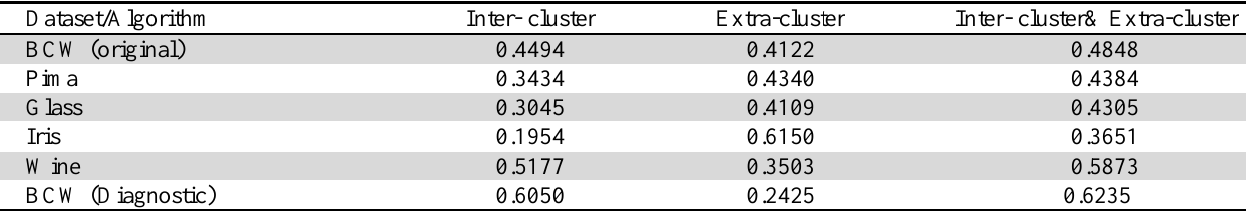
The results o cluster dista Dataset/Algo BCW